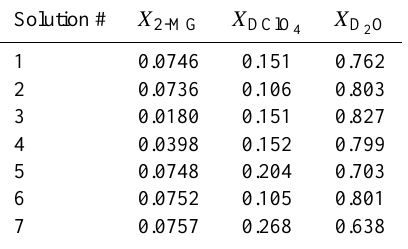
= 0 . 001–0.02) and 4